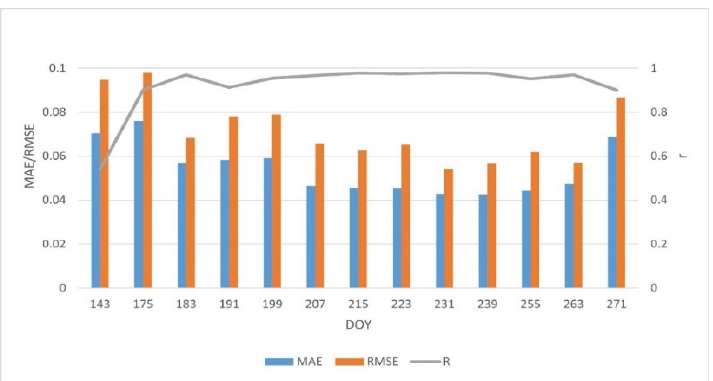
Figure 4. Bar graph of NDVI predictions statistics (mean average error (MAE), root-mean-square error (RMSE), and r ) at the CSD area. Table 2. Quantitative validation of NDVI for all input days at the CSD area.